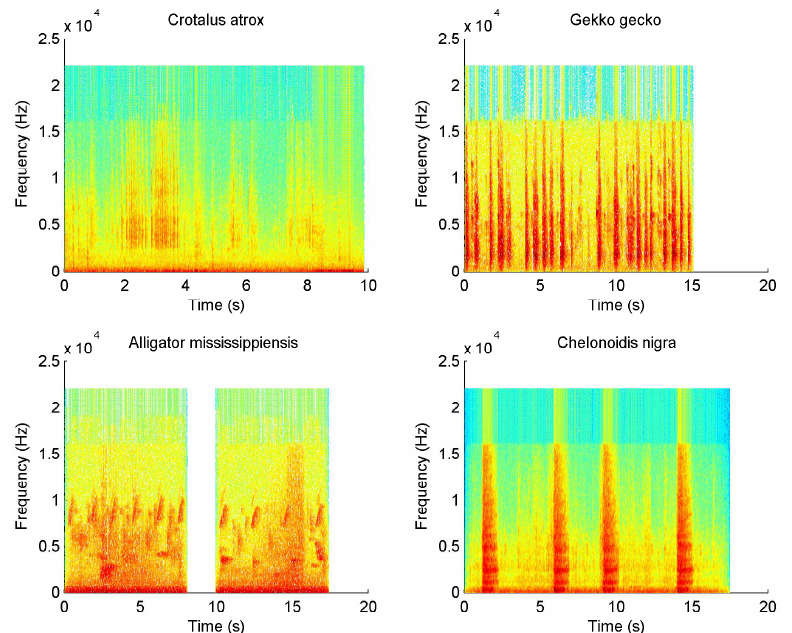
Figure 2. Example of four reptile call